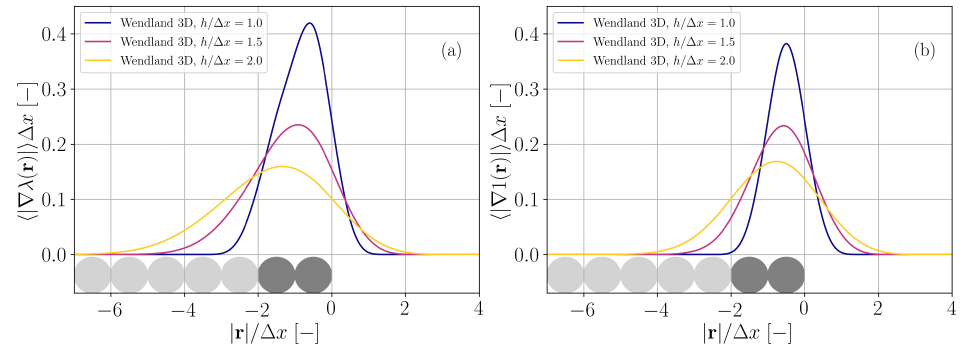
Figure A2. Normalized gradients of the functions from Figure A1. ( a ) Based on the minimum eigenvalue of the inverse renormalization tensor. ( b ) Based on the unity